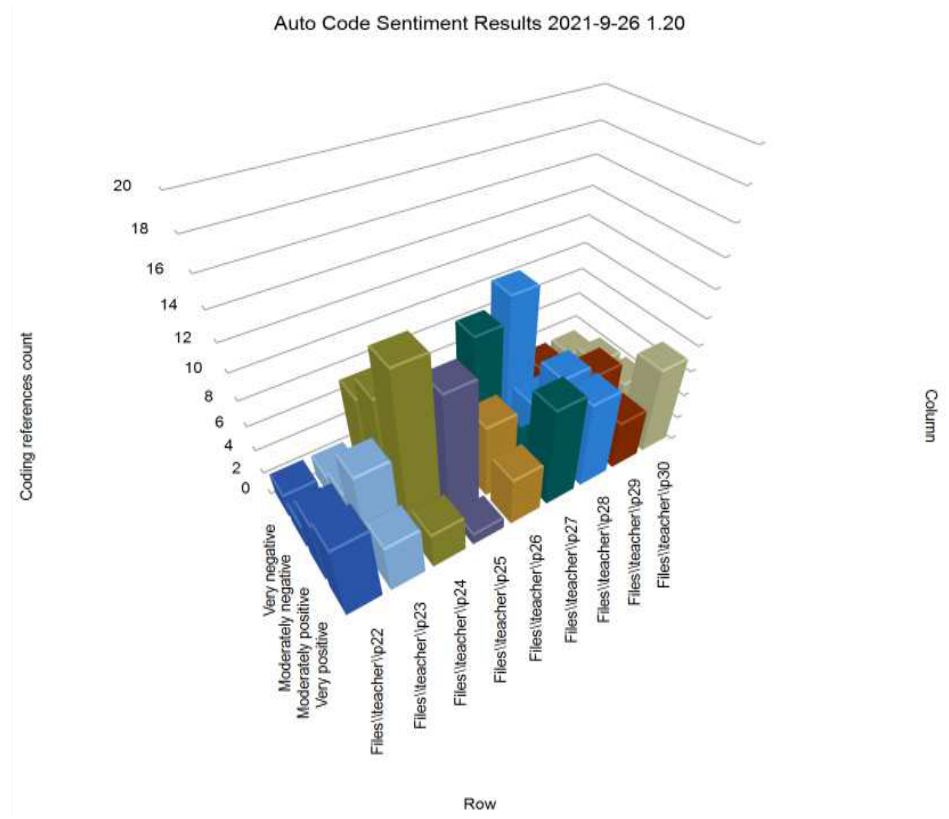
Figure 4. Matrix of teachers’ attitudes towards digitalization in